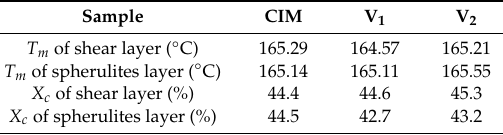
Figure 3. Differential scanning calorimeter (DSC) melting curves of different layers of samples, ( a ) Figure 3. Di ff erential scanning calorimeter (DSC) melting curves of di ff erent layers of samples, ( a ) shear shear layer, ( b ) spherulites layer. layer, ( b ) spherulites layer. Table 2. Melting temperature and crystallinity of di ff erent layers of samples. Table 2. Melting temperature and crystallinity of different layers of samples.